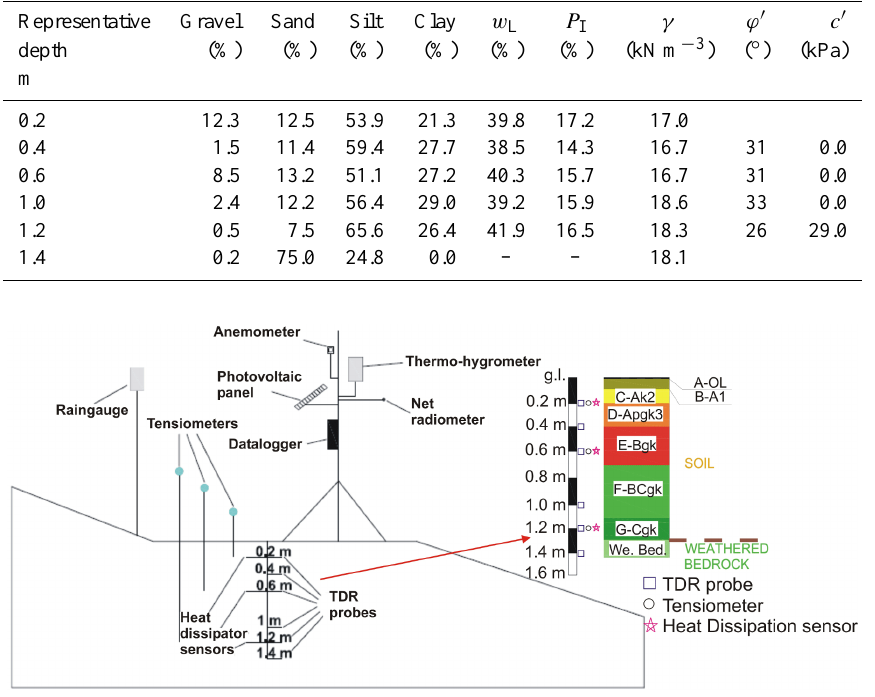
Table 1. Selected geotechnical and mechanical features of the monitored slope soil and weathered bedrock: grain size distribution (gravel, sand, silt, clay), liquid limit ( w L ), plasticity index ( P I ), unit weight ( γ ), friction angle ( ϕ (cid:48) ), cohesion ( c (cid:48) ).